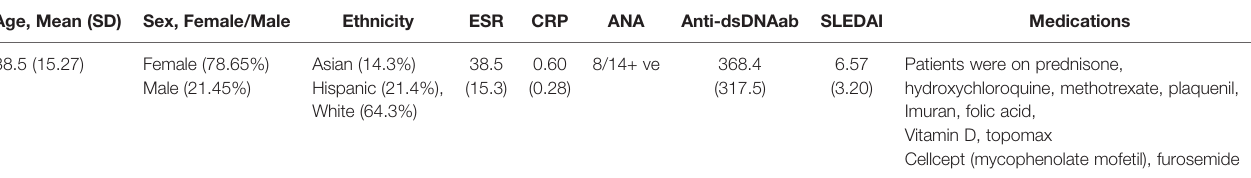
Data are presented as medians, means (SD) or number (%) as indicated. Age range was between 20-72 years, ESR (Erythrocyte sedimentation rate) range was 3-31, CRP (C- reactive protein) range was in between 0.5-1.5, ANA (Anti-nuclear antibody) was positive in 8 patients out of 14. 6 had < 1:40, Anti-dsDNA Ab (Anti-double strand DNA Ab) range was